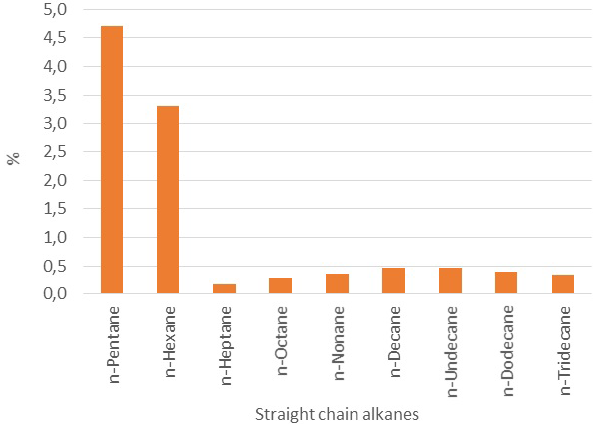
Figure 7. Contribution of double hydride abstraction (DHA) to charge transfer (CT), calculated using weighted sensitivities ) cpsppbv − 1 ] normalized to O + [w(O + 2